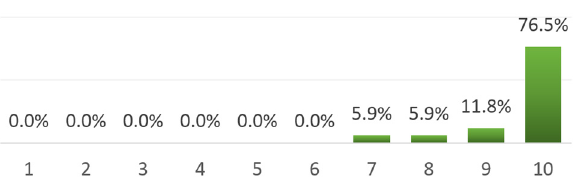
Figure 10. Does force imaging with LED help to better understand the work of individual compo- nents? (nodes, bars, supports)? (1—no, 10—very).